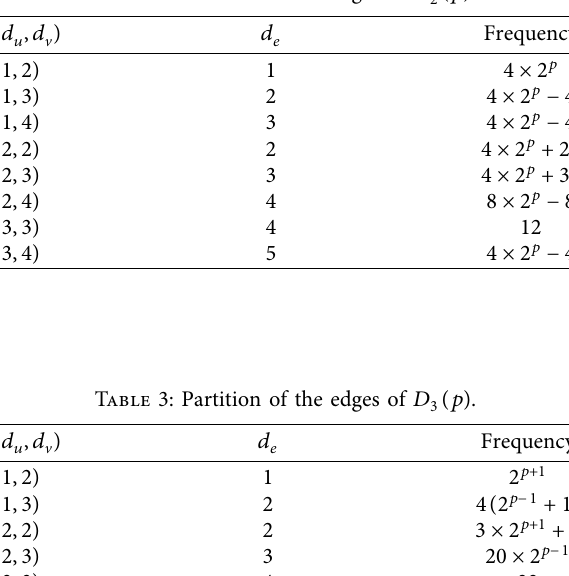
Table 2: Partition of the edges of D